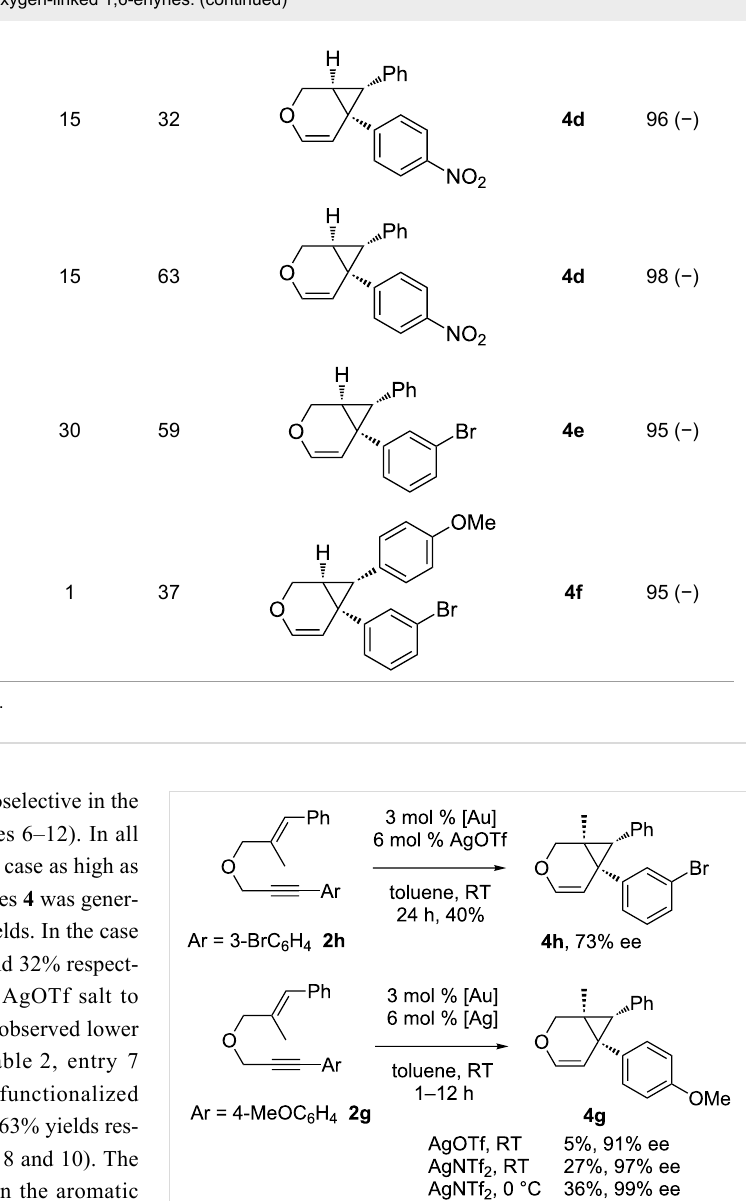
Table 2: Cycloisomerization reaction of nitrogen- and oxygen-linked 1,6-enynes.